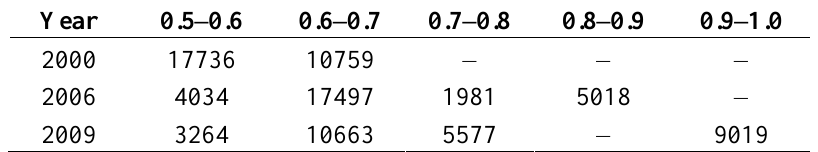
Table 9. Unit demand index of land ecological security in Guangzhou city.